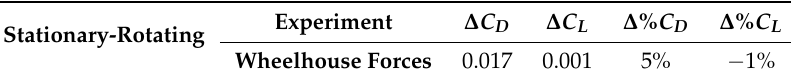
Table 3. Experimental wheelhouse forces: stationary-rotating.